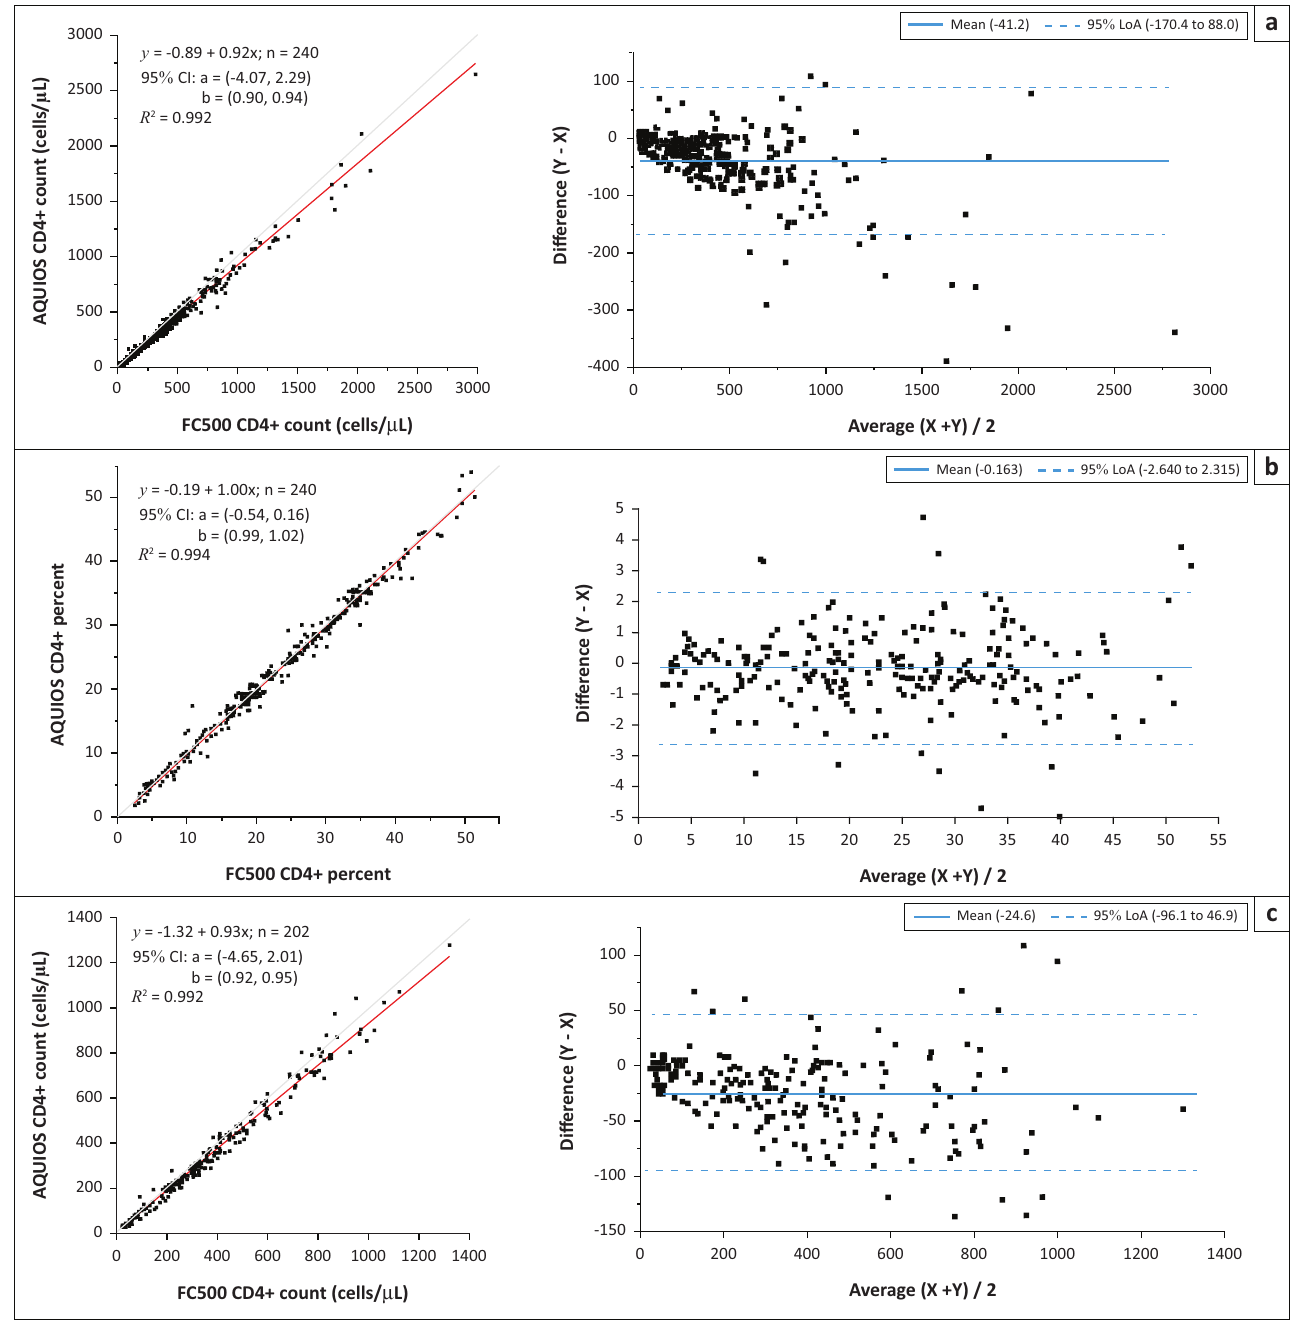
FIGURE 2: Deming regression and Bland-Altman for AQUIOS PanLeucogating versus Flowcare PanLeucogating, Canada; Paris, France; Lyon, France; and South Africa, November 2014 to March 2015. (a) Absolute CD4 count in cells/ μ L for adults and children, (b) Percentage of CD4 for adults and children, (c) Absolute CD4 count in cells/ μ L for adults